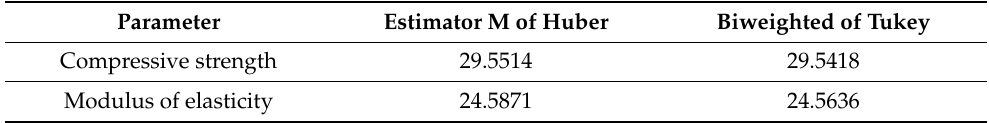
Figure 11. Statistical analysis with M estimators. ( a ) Applied on compressive strength. ( b ) Applied on modulus of elasticity. Table 11. Statistical analysis with estimators M. Table 12. Statistical analysis with different mesh. Table 11. Statistical analysis with estimators